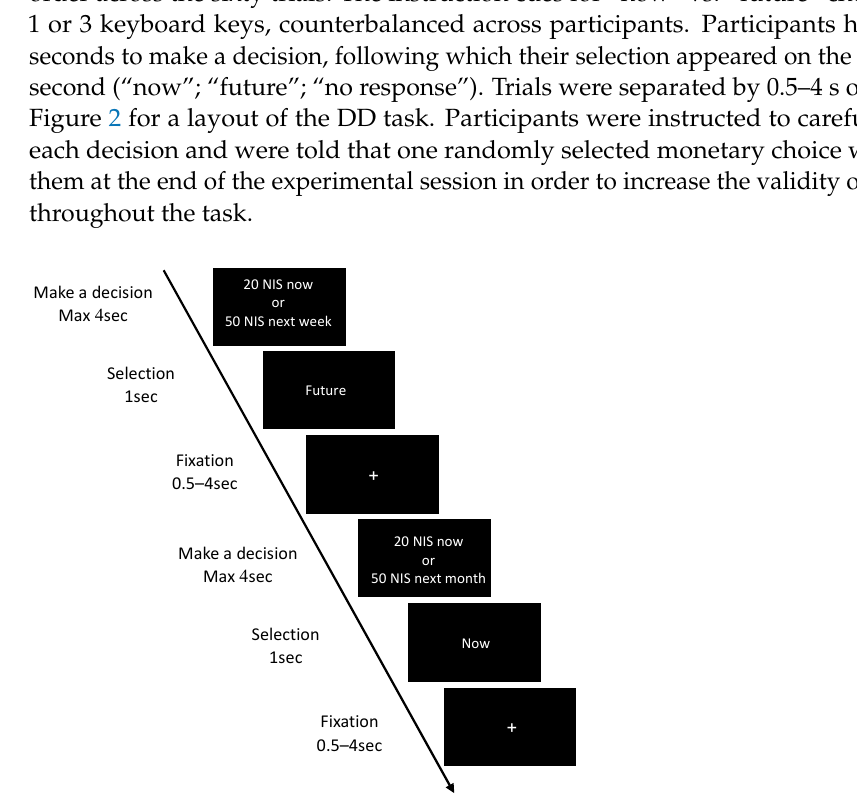
Figure 2. Layout of the delay discounting (DD) task. This well-established task assesses behavioral indices of choice impulsivity (CI) by asking participants to decide whether they want 20 NIS right now (at the end of the experiment) or one of 10 larger monetary amounts after one of six delays. Each combination of an amount and delay appeared once in a randomly counterbalanced order across the sixty task trials. NIS—New Israeli